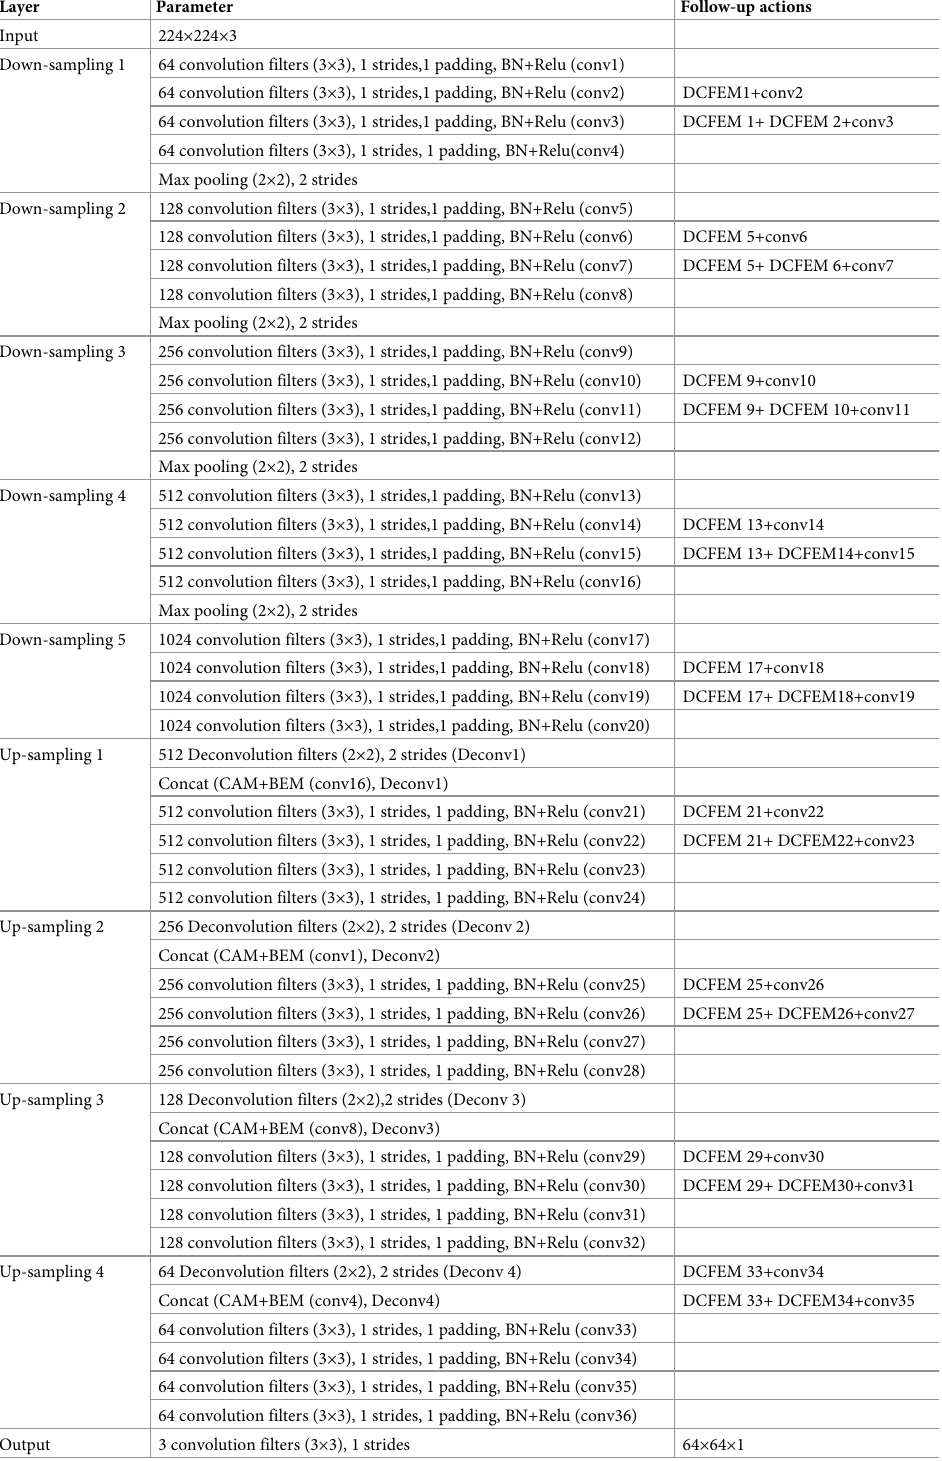
Table 1. Network